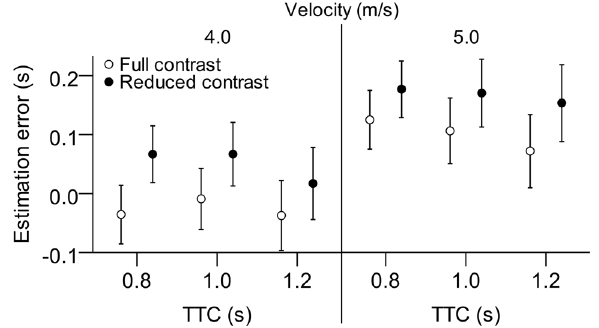
Figure 4. Mean TTC estimation errors (estimated TTC—actual TTC) as a function of velocity, simulated TTC and reduced contrast. Error bars represent ± 1 standard error of the mean across participants.